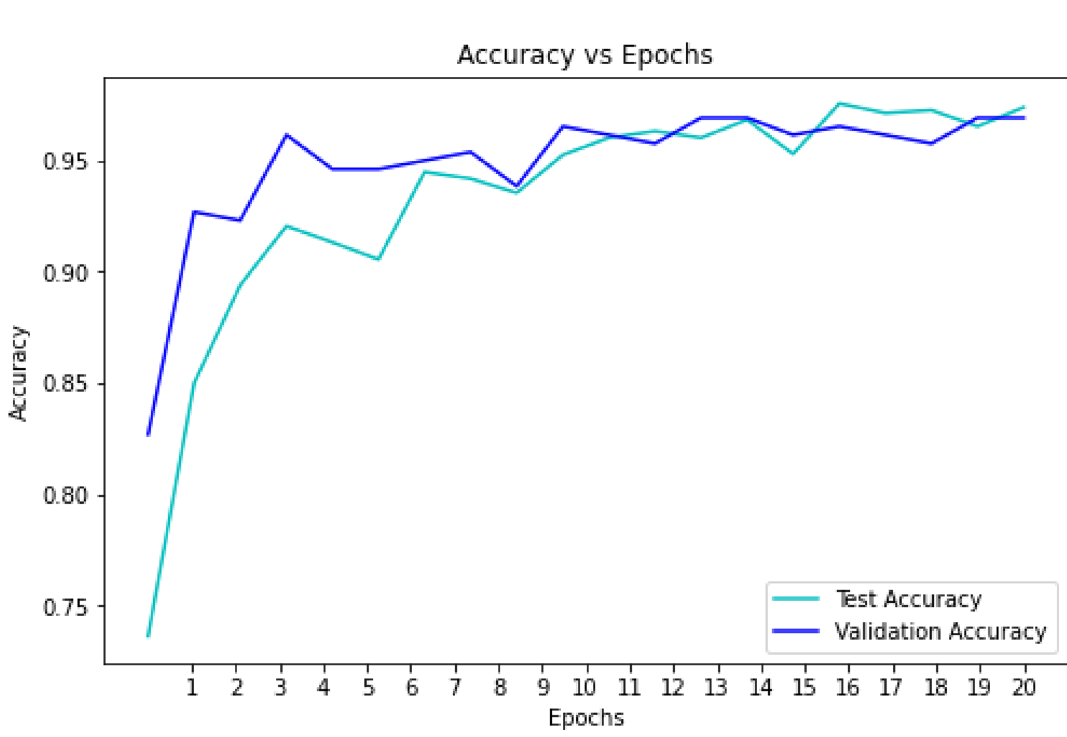
Figure 7. Model Accuracy